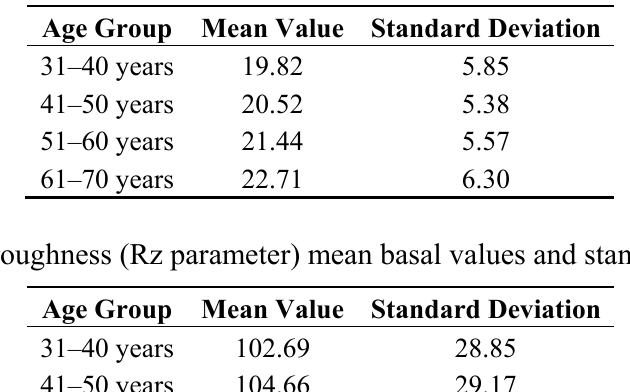
Table 3. Skin roughness (Ra parameter) mean basal values and standard deviations.